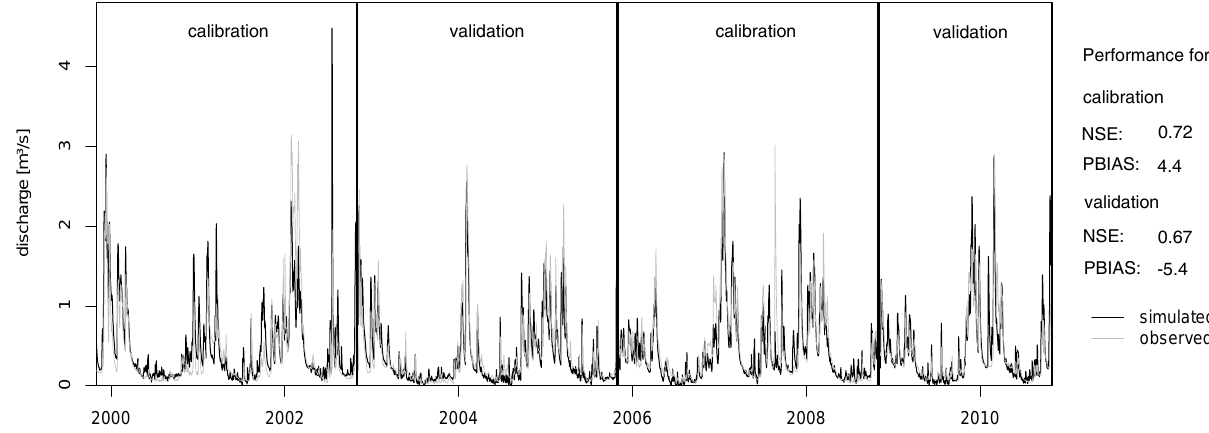
Figure 5. Daily observed (grey) and simulated (black) discharge for the study catchment with model performance (Nash–Sutcliffe efficiency (NSE) and percent bias (PBIAS)) for the calibration and validation period after Pfannerstill et al. (2014b).